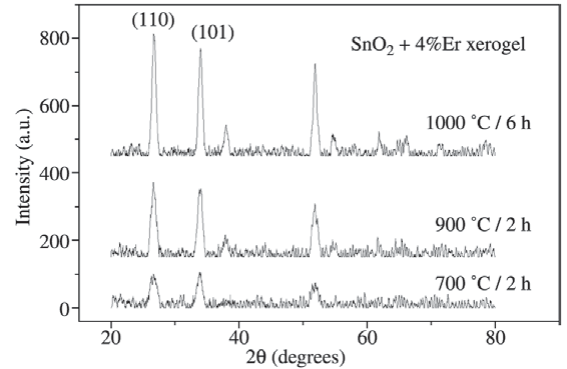
:4%Er thin film treated 2